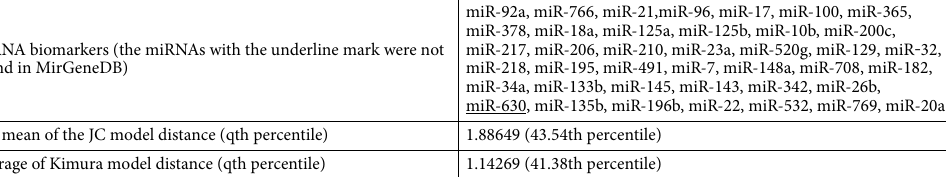
miRNA biomarkers (the miRNAs with the underline mark were not found in MirGeneDB)